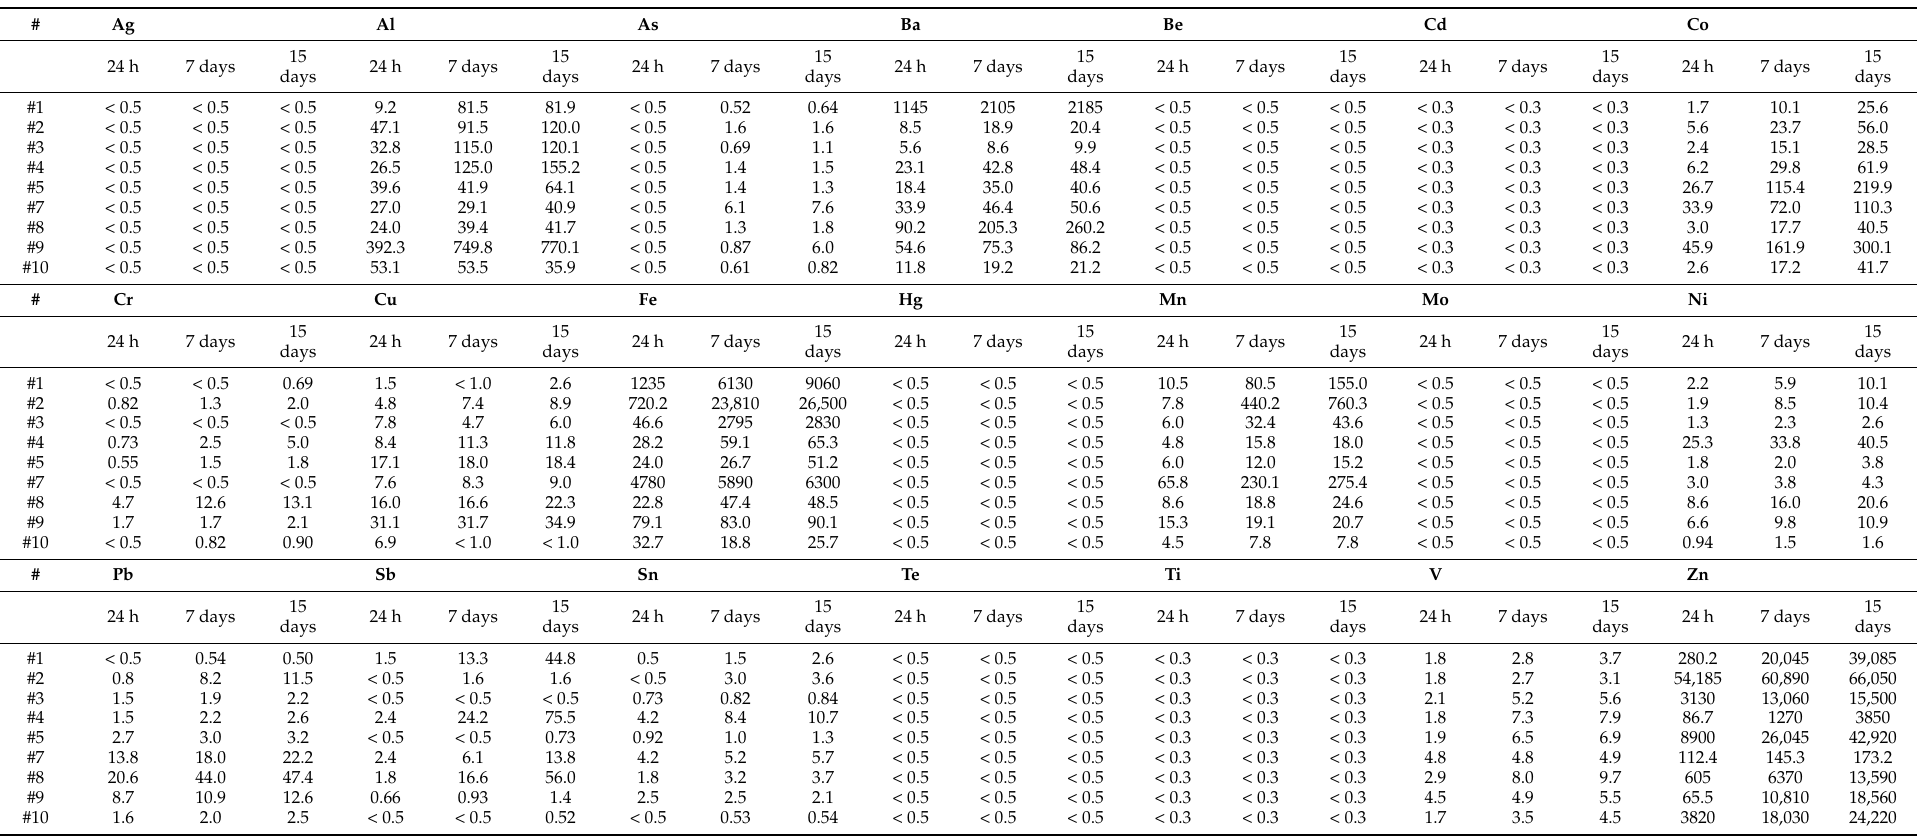
Table 4. Heavy metal levels ( µ g kg − 1 ) determined by ICP-MS after leaching tests at different times on the investigated samples, performed according to the CNR IRSA method [15]. For sample identification, see Table 2. Release tests were not performed on sample #6, i.e., Sant Klaus, due to the sample availability; #9—gladiator with gladius (i.e., a Roman sword); and #10—Pope with red cross and